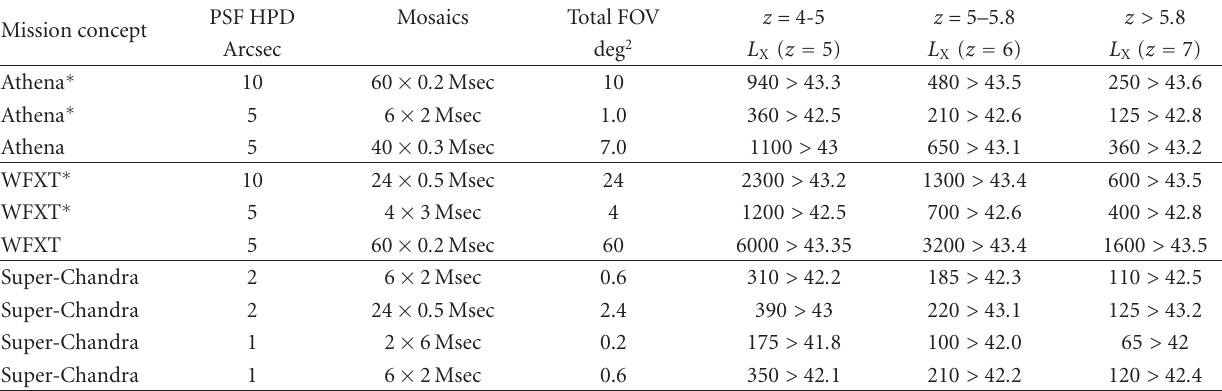
Table 2: Predicted number of faint, high- z X-ray